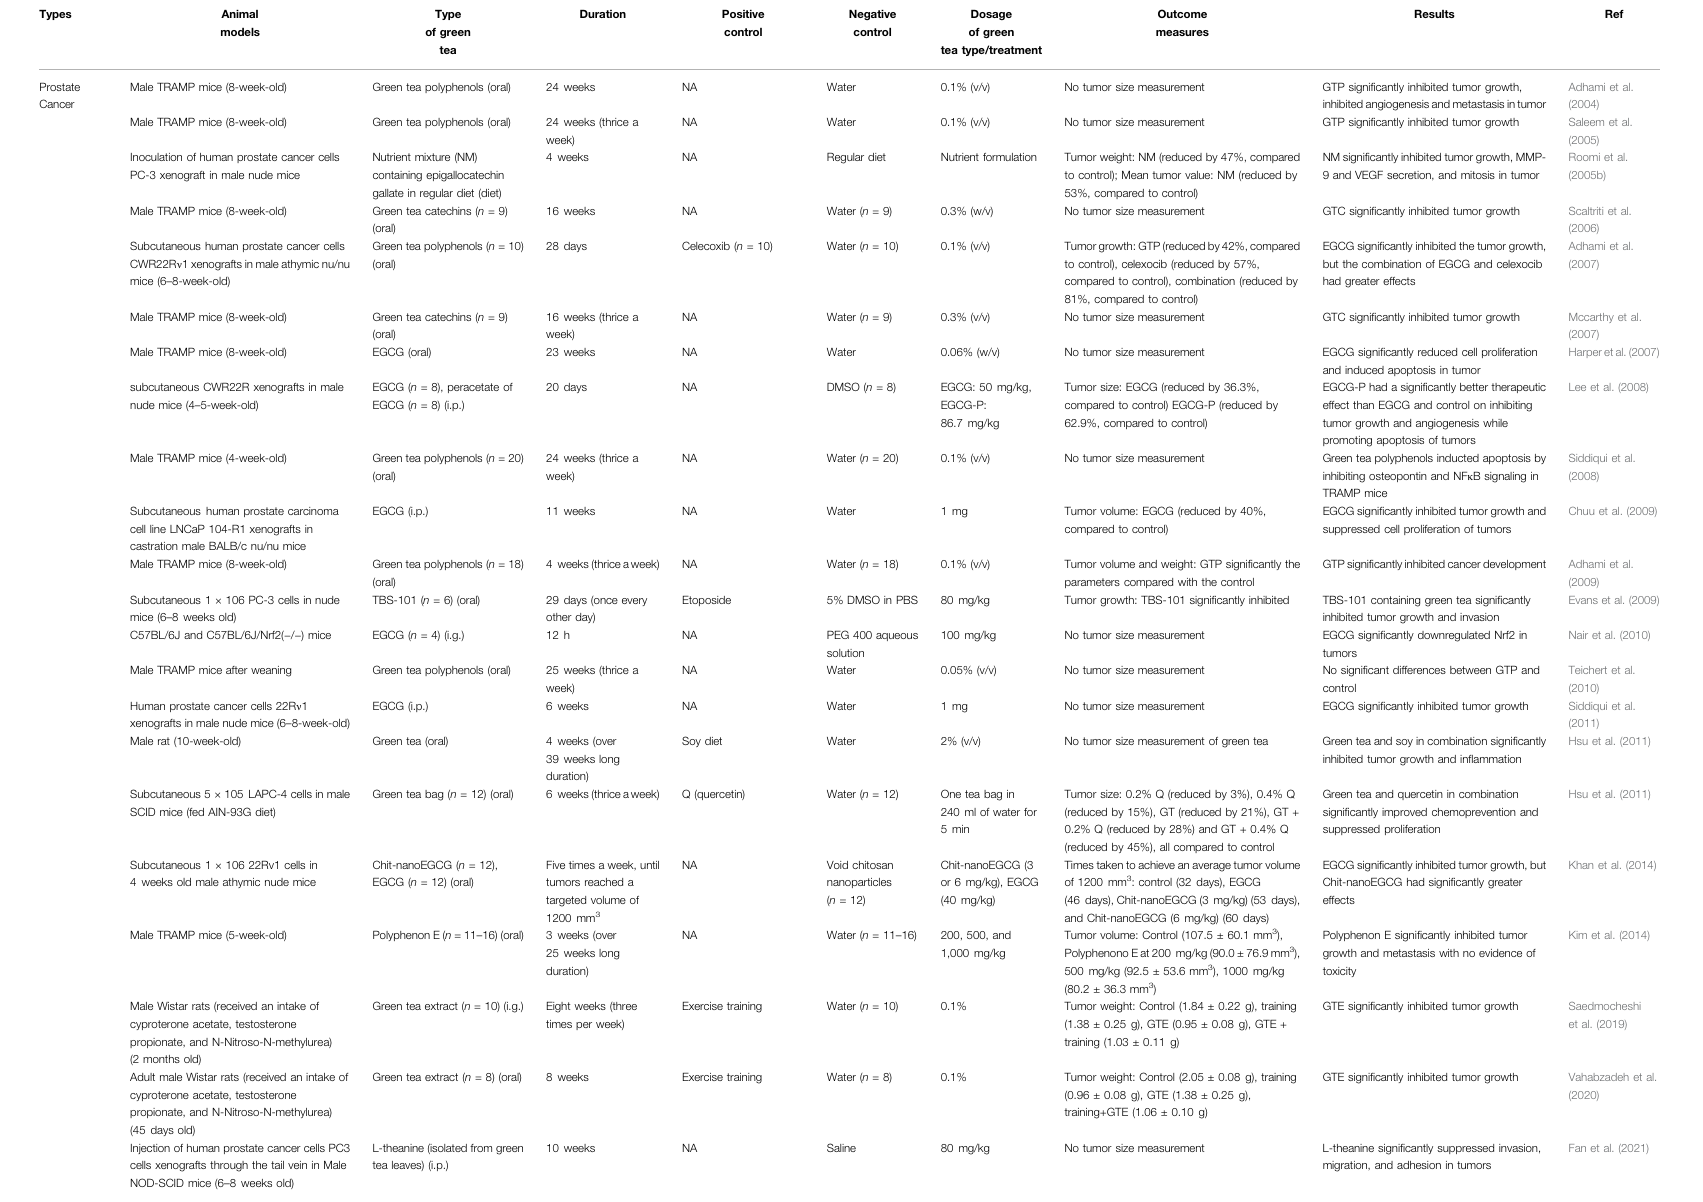
TABLE 2 | ( Continued ) Effects of Green tea on reproductive cancers in animal models.